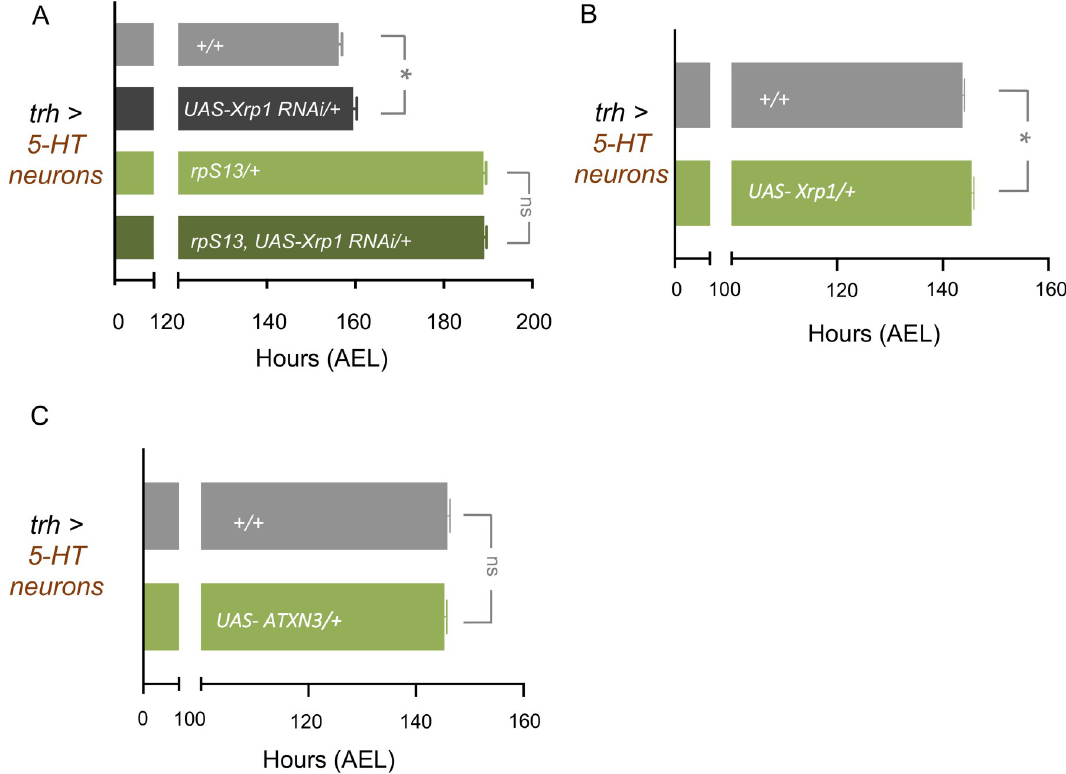
Fig 6. Inducing proteotoxic stress in 5-HT neurons does not recapitulate a Minute phenotype. (A) Time to pupation of +/+ and rpS13/+ larvae with or without RNAi knockdown of Xrp1 (UAS-Xrp1 RNAi) in serotonergic neurons using Trh-Gal4 . +/+ n = 200, UAS-Xrp1RNAi/+ n = 160, rpS13/+ n = 179, UAS-Xrp1RNAi/rpS13 n = 203. Data are presented as +/- SEM. � p < 0.05, Mann- Whitney U test. (B) Time to pupation of control larvae and larvae with UAS- Xrp1 overexpression in 5-HT neurons using trh-gal4 . +/+ n = 242, +/ UAS-Xrp1 n = 202. Data are presented as +/- SEM. � p < 0.05, Mann-Whitney U test. (C) Time to pupation of control larvae and larvae with UAS- ATXN3 overexpression in 5-HT neurons using trh-gal4 . +/+ n = 162, +/ UAS-ATXN3 n = 163. Data are presented as +/- SEM. ns = not significant, Mann-Whitney U